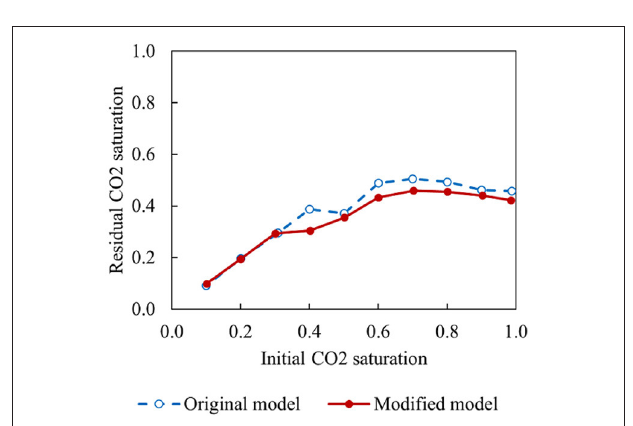
imbibition threshold P c equations of pore-body filling and snap-